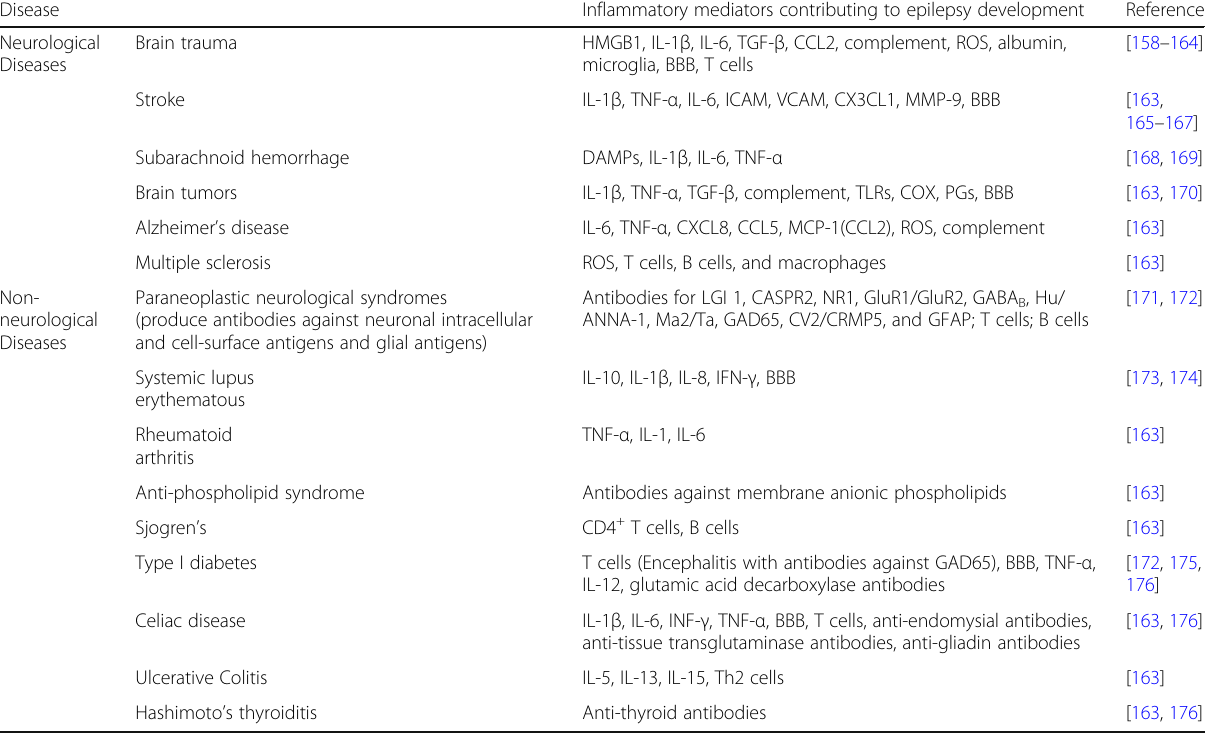
Table 1 Neurological and non-neurological diseases associated with epilepsy and the related inflammatory mediators